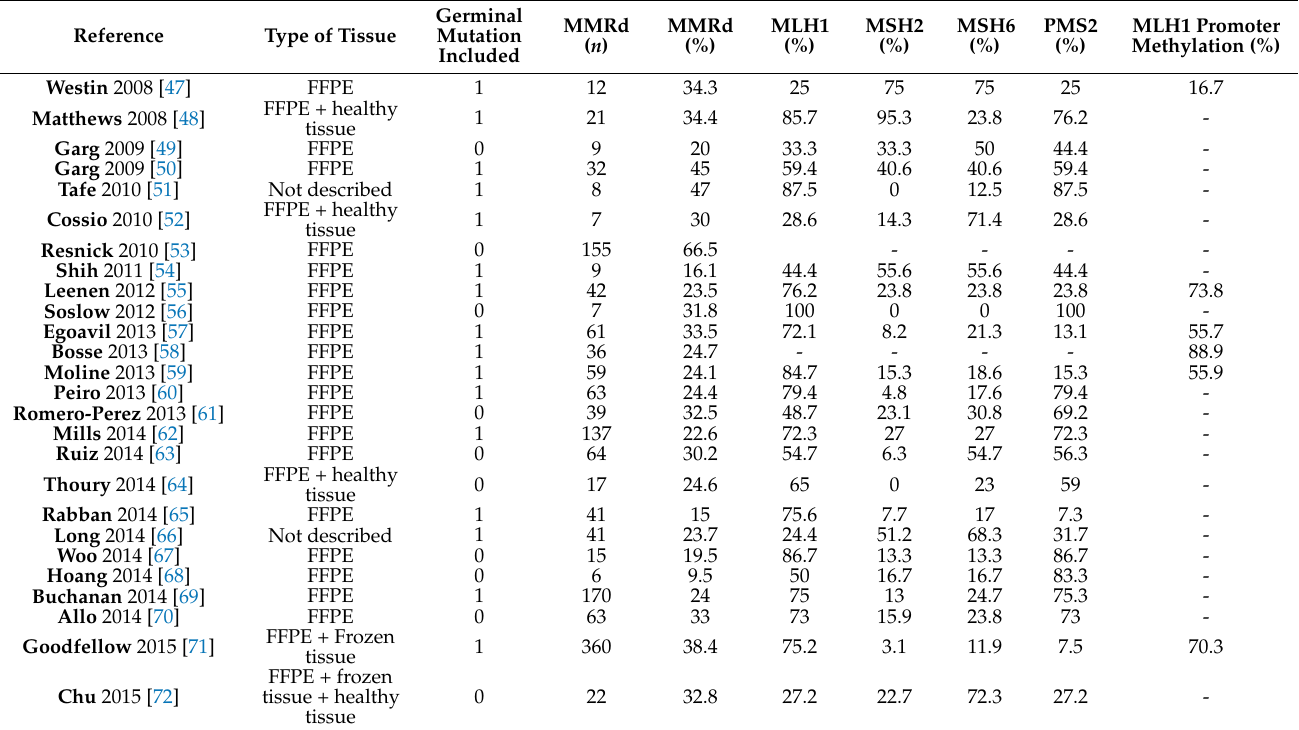
Table 3. Differences in immunohistochemistry protein losses in tumors with microinstability in endometrial cancer using expression of four